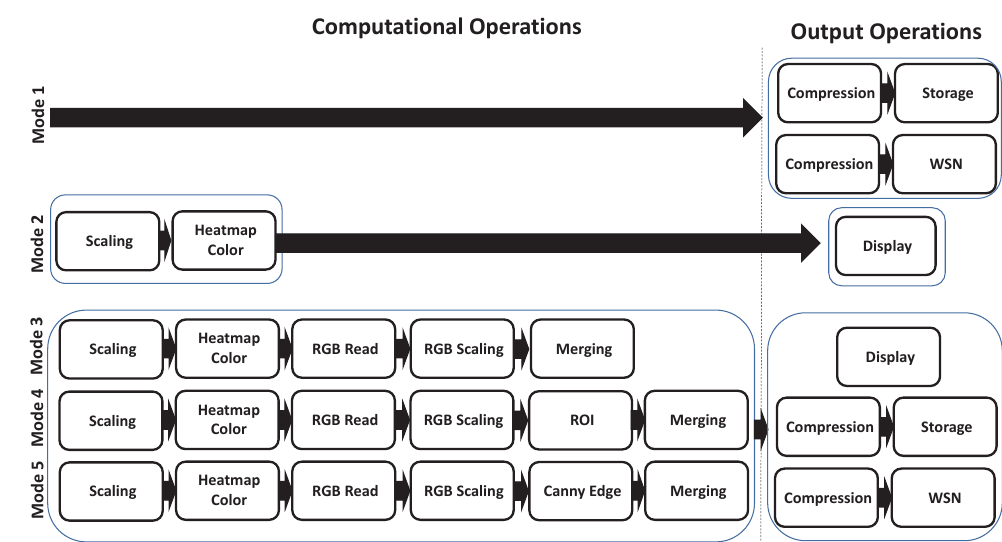
Figure 8. Overview of the image processing steps executed on the CPU. Multiple modes are supported to satisfy the most constrained Wireless Sensor Networks (WSN)